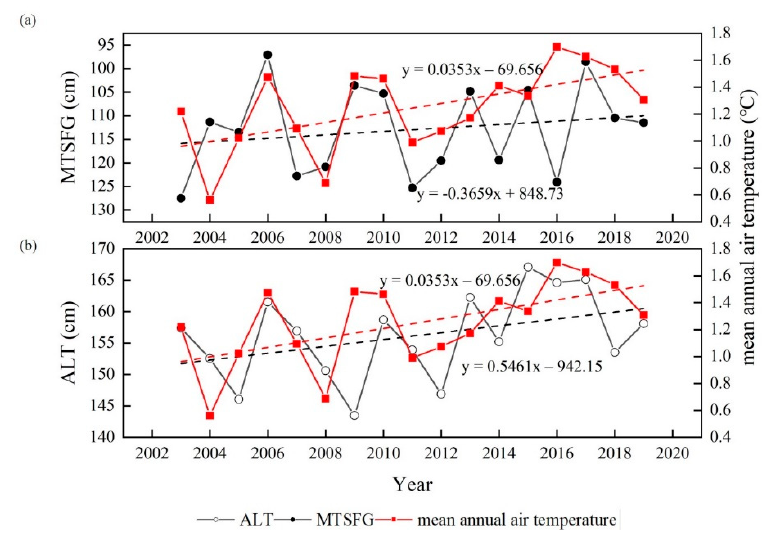
Figure 6. Changes in the basin-averaged ( a ) MTSFG and ( b ) ALT of the permafrost estimated by remote sensing. The observed mean annual air temperature in the period from 2003 to 2019 are also shown in the figure.